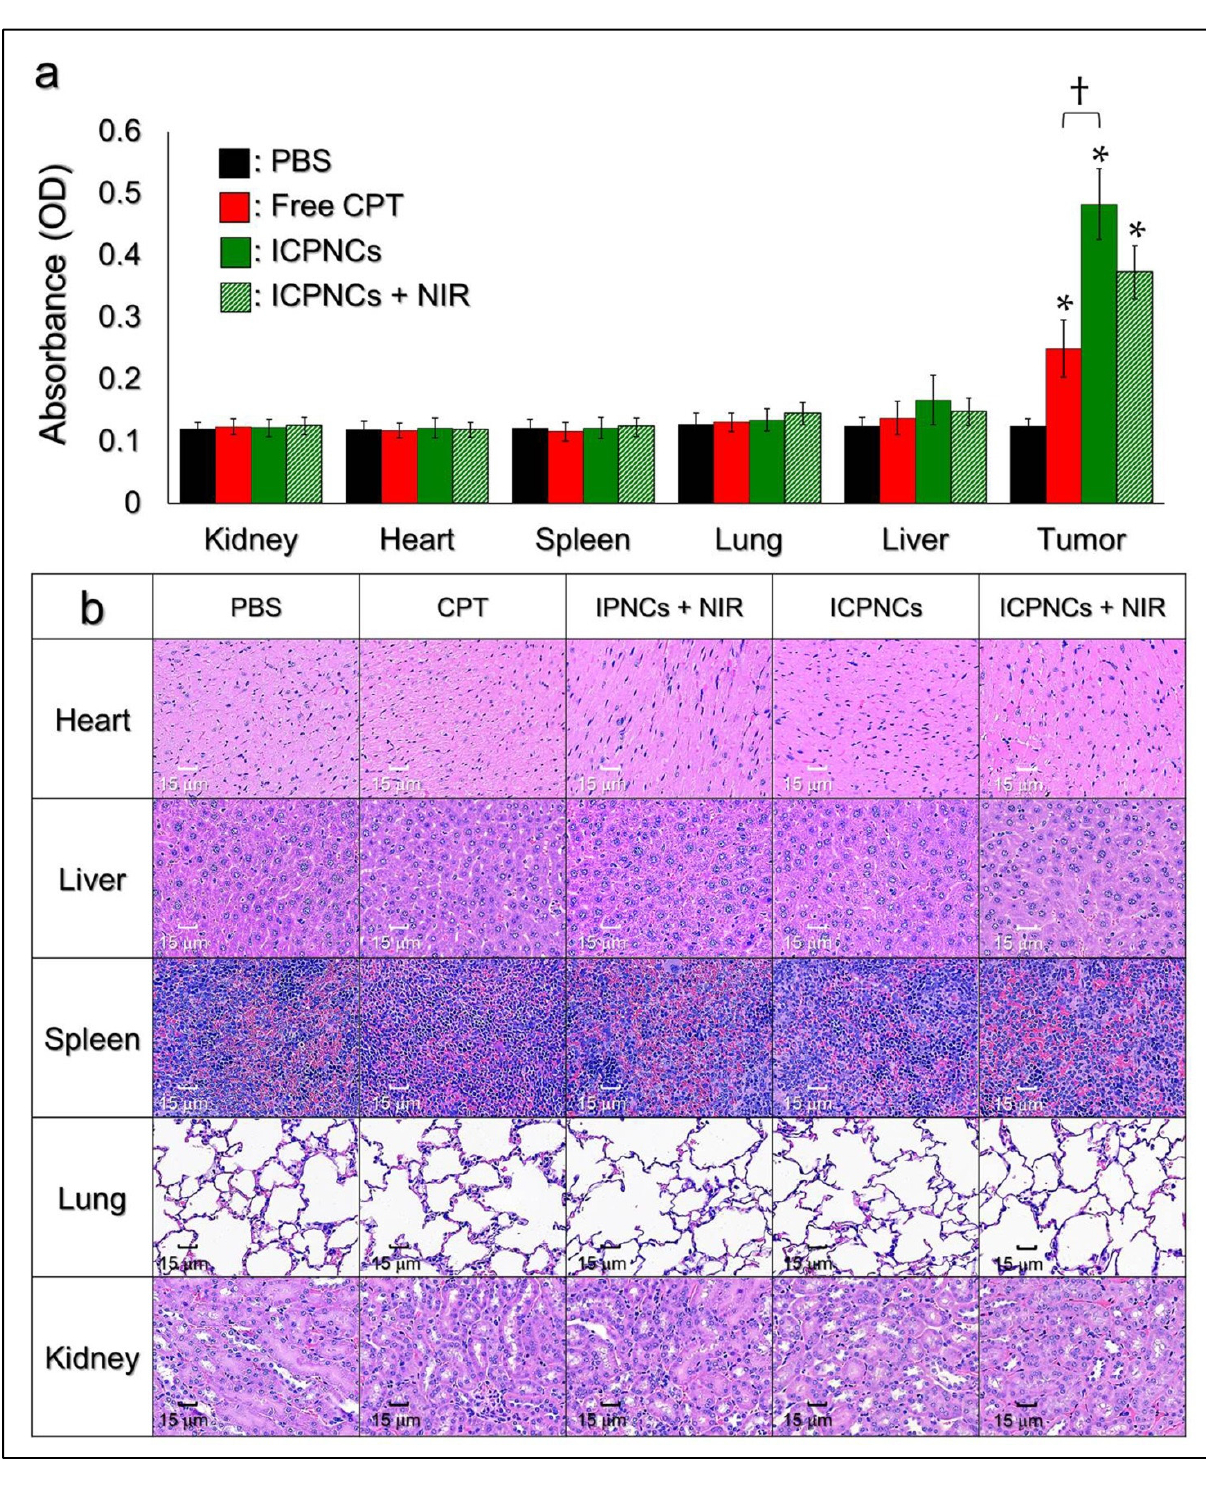
Figure 9. In vivo toxicological study of the ICPNCs. ( a ) Quantitative analyses of the amounts of CPT remaining in the heart, liver, spleen, lung, kidney, and tumor of the MDA-MB-231 tumor-bearing nude mice after treatment with PBS, CPT, ICPNCs, or ICPNCs + NIR for 21 days. Values are the mean ± s.d. ( n = 5). * p < 0.05 compared to the value obtained from the group with PBS for the same organ. † p < 0.05. ( b ) Photomicrographic images of H&E-stained heart, liver, spleen, lung, and kidney obtained from the MDA-MB-231 tumor-bearing nude mice with various treatments for 21 days as indicated in the figure.